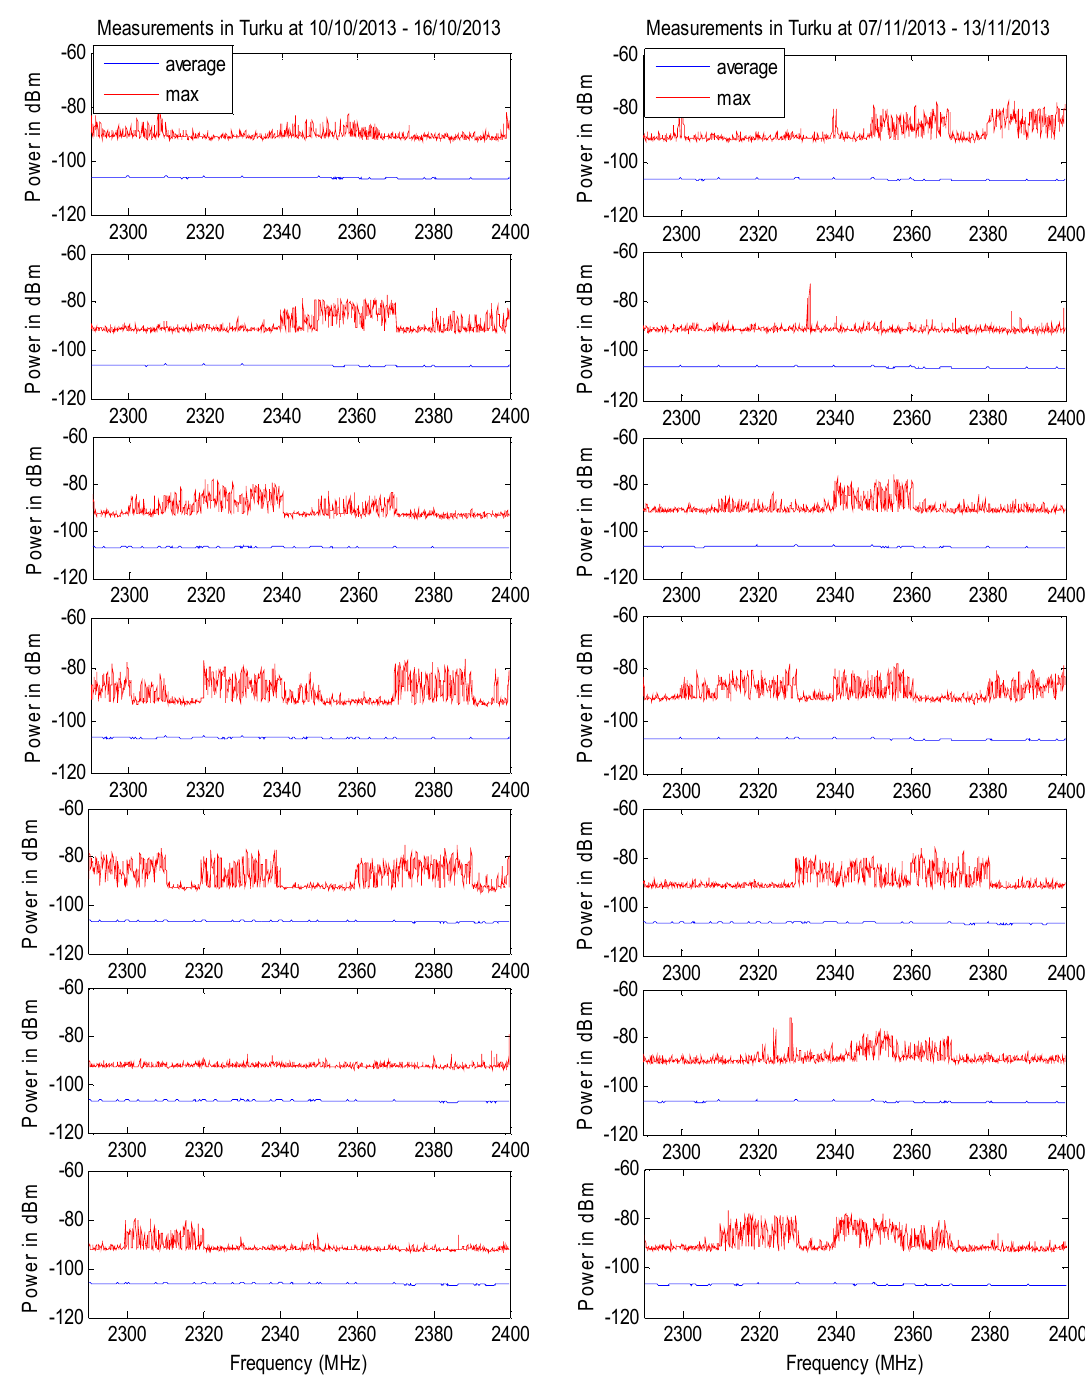
Figure 4 . Average (blue) and maximum (red) power spectrum in 2.3 GHz at Turku, Finland. Each column represents a week and a row in a column represents a